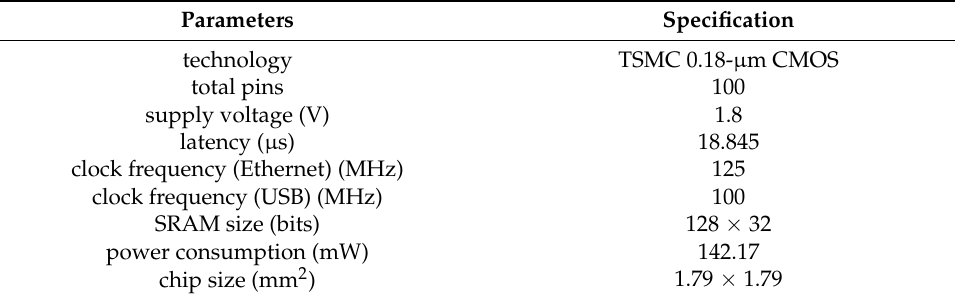
Figure 24. Circuit blocks of the proposed bridge ASIC using RTL Viewer software. Table 1. Specifications of the proposed Ethernet and USB bridge